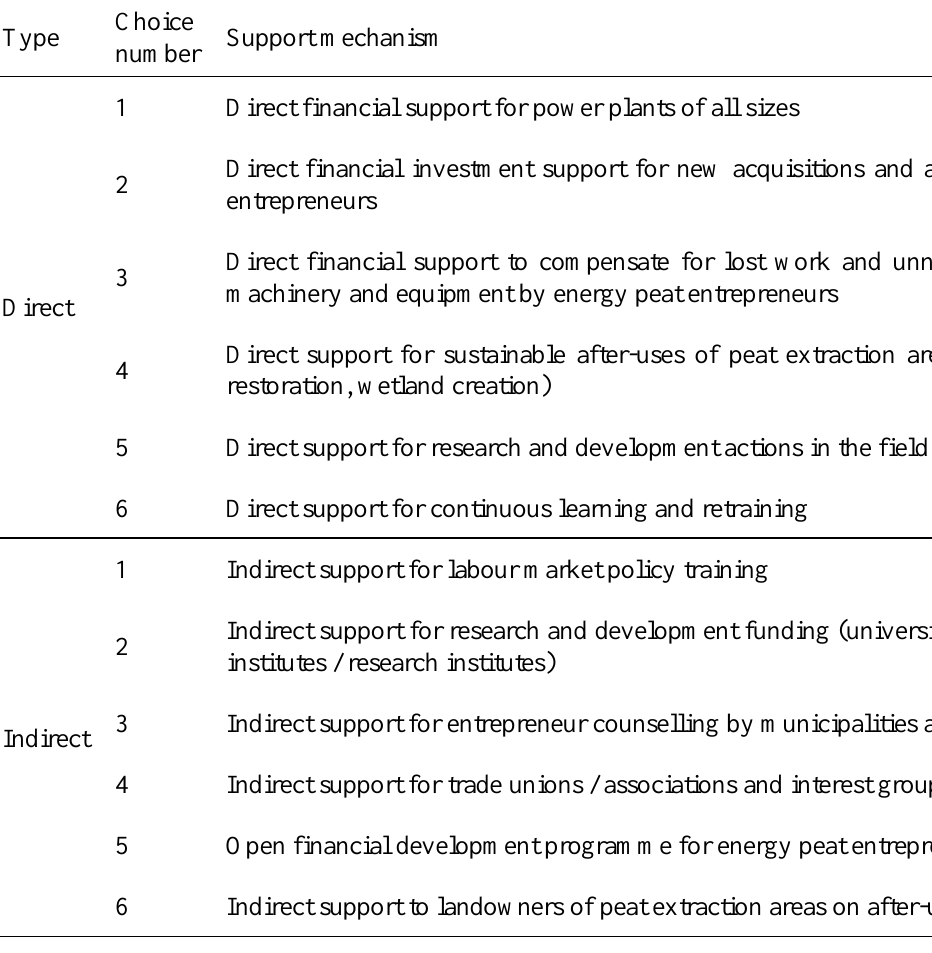
Table 1. The support mechanism choices (direct and indirect) offered in the